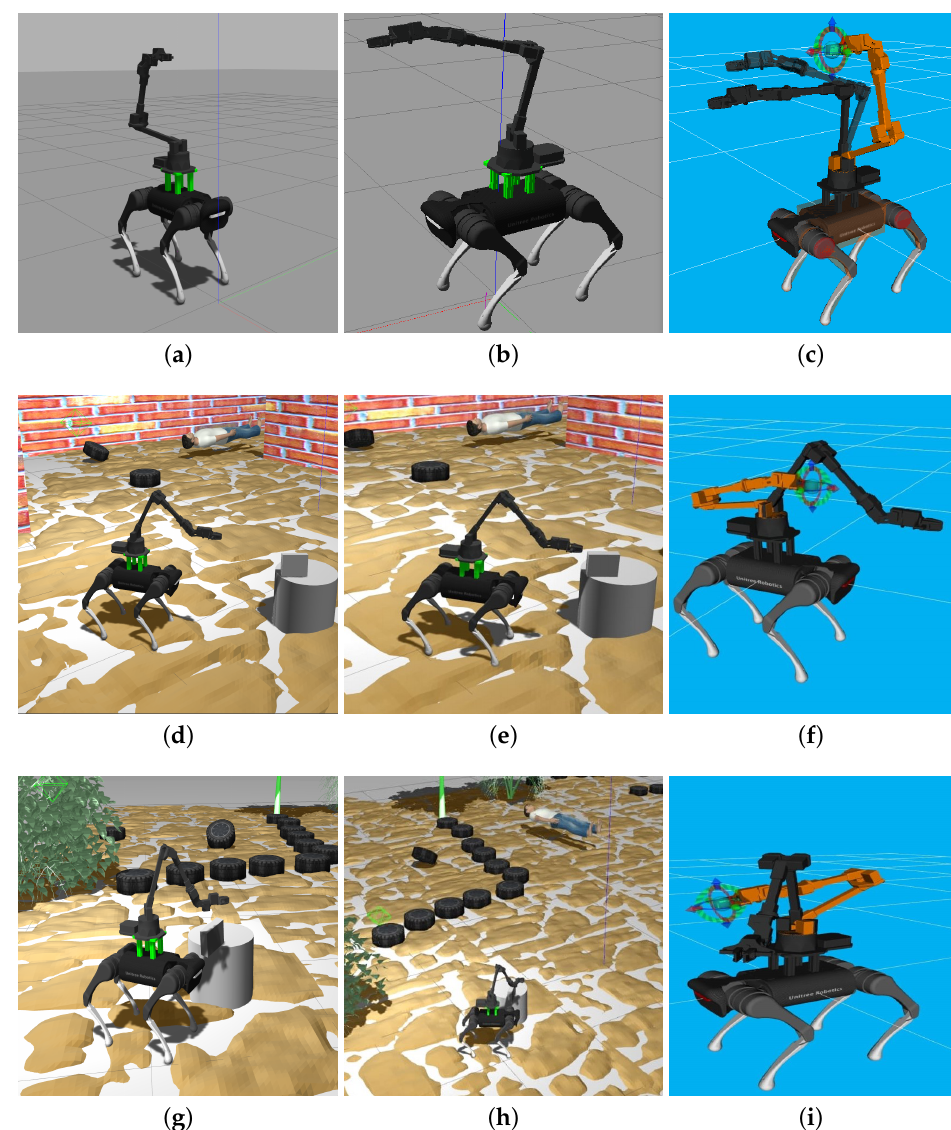
Figure 3. Simulation of the Legged-Manipulator Robot for manipulation tests using Movement Planning (MoveIt) in different Gazebo environments. ( a ) Simulation of the robotic set in Gazebo. ( b ) Simulation of the robotic set in Gazebo. ( c ) Collision free path trajectory planned by Moveit. ( d ) Simulation of Manipulation with the robot set (indoors). ( e ) Simulation of Manipulation with the robot set (indoors). ( f ) Planning of movements by MoveIt. ( g ) Simulation of Manipulation with the robot set in Gazebo (outdoors). ( h ) Manipulation simulation in Gazebo (outdoors). ( i ) Planning of movements by